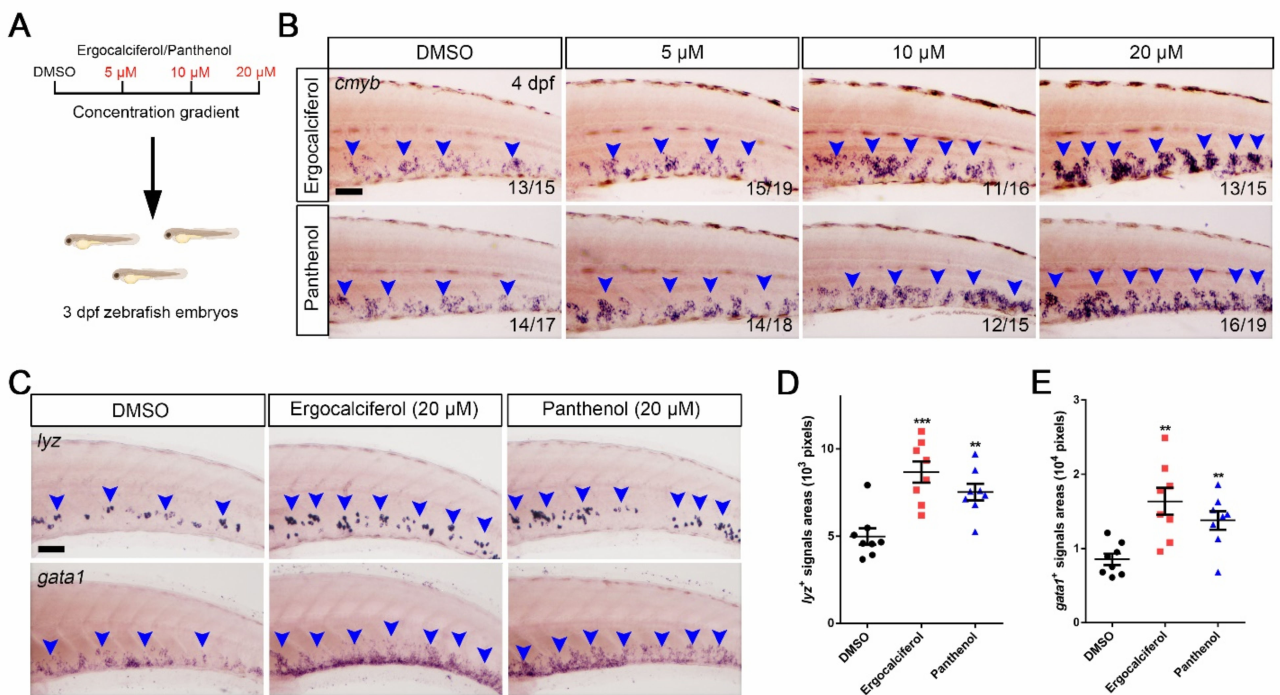
Figure 4. Ergocalciferol and panthenol facilitate HSPCs expansion in a dosage-dependent manner. ( A ) Schematic diagram of concentration gradient using ergocalciferol and panthenol. ( B ) WISH of cmyb with different concentration (5, 10, 20 µ M). Blue arrowheads indicate cmyb + signals. ( C ) WISH of lyz (upper) and gata1 (bottom) after treating with ergocalciferol and panthenol using 20 µ M. ( D , E ) Quantification of lyz + (left) and gata1 + (right) signals areas in the CHT region. (Pixels, lyz + signals; DMSO, 4980 ± 467; Ergocalciferol, 8678 ± 617; Panthenol, 7524 ± 468; gata1 + signals; DMSO, 8525 ± 768; Ergocalciferol, 16,350 ± 1816; Panthenol, 13,790 ± 1252). Scale bar, 50 µ m; Mean ± SEM, n = 8; ** p < 0.01, *** p <0.001.